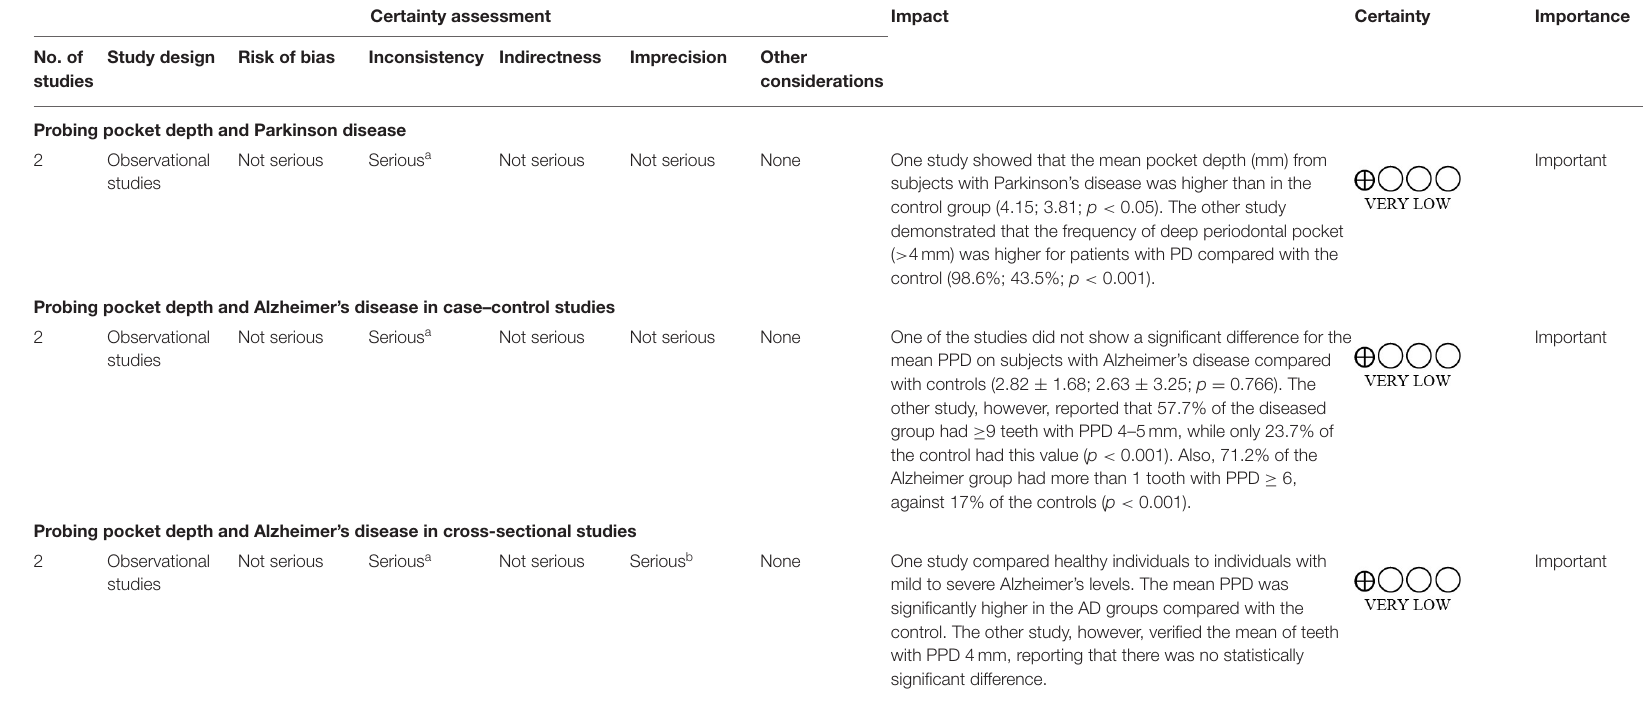
TABLE 3 | Level of evidence by Grading of Recommendations Assessment, Development and Evaluation (GRADE) approach. Certainty assessment Impact Certainty